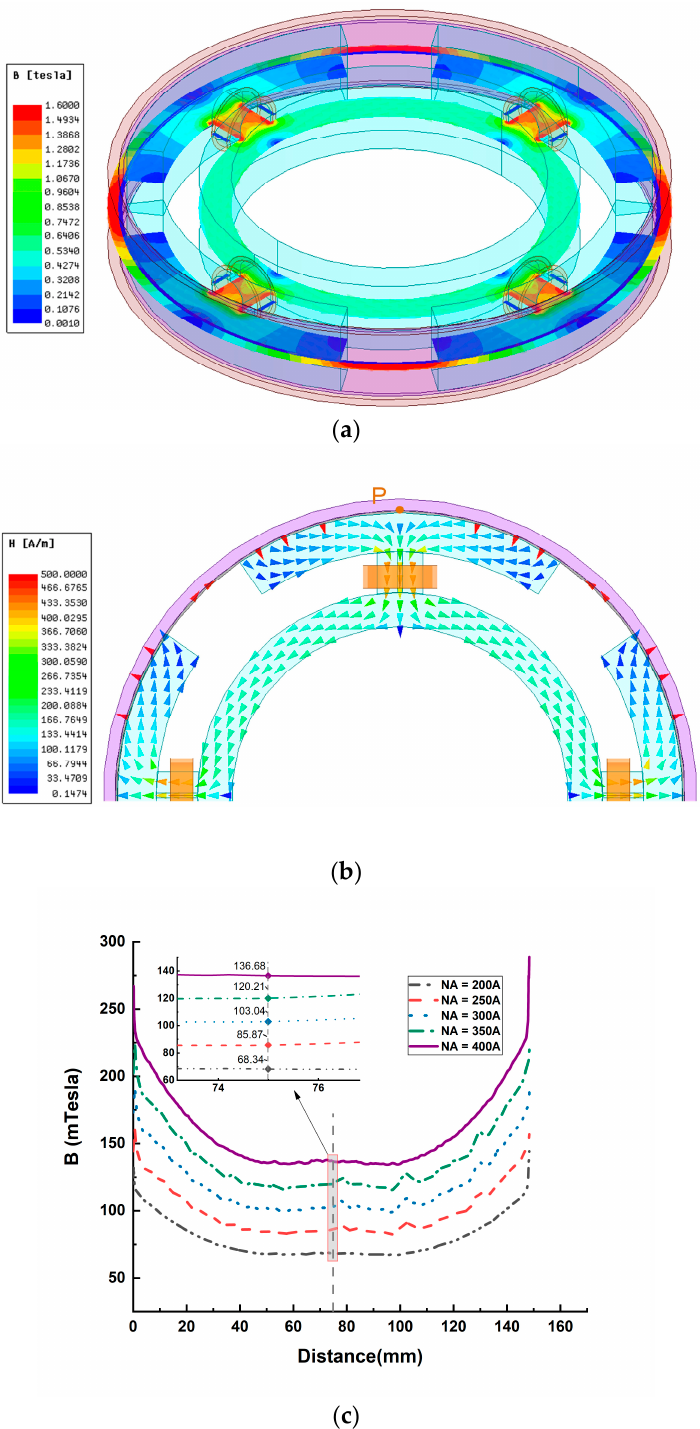
Figure 13. Magnetic field analysis of circumferential configuration: ( a ) distribution diagram of mag- netic field; ( b ) distribution diagram of magnetic flux density; ( c ) magnetic field strength distribution in the path where point P is located.